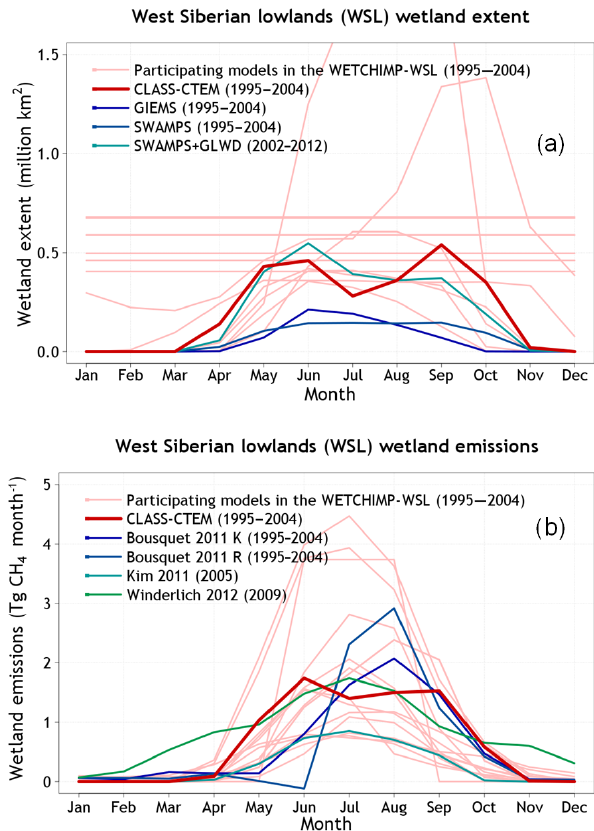
Figure 9. Comparison of CLASS-CTEM simulated wetland ex- tent ( a ) and wetland methane emissions ( b ) over the West Siberian lowlands (WSL) region with those from models participating in the WETCHIMP-WSL intercomparison and observation- and inversion-based estimates as discussed in Sect.